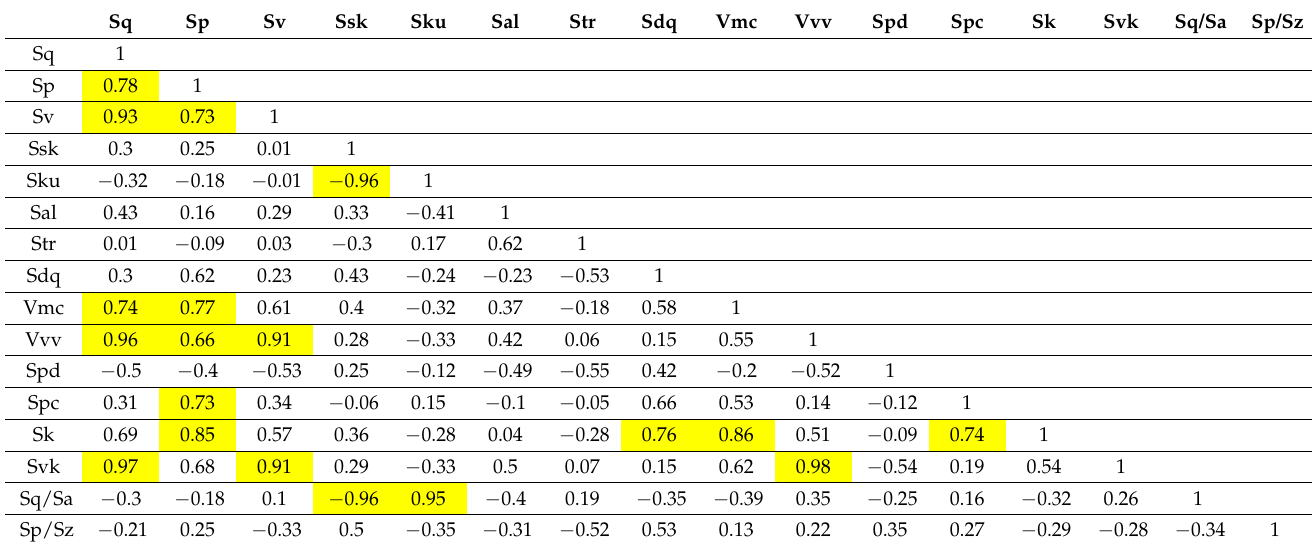
Table 2. Coefficients of linear correlation between selected parameters of surfaces that contain isolated oil pockets, the strong correlations are marked by yellow